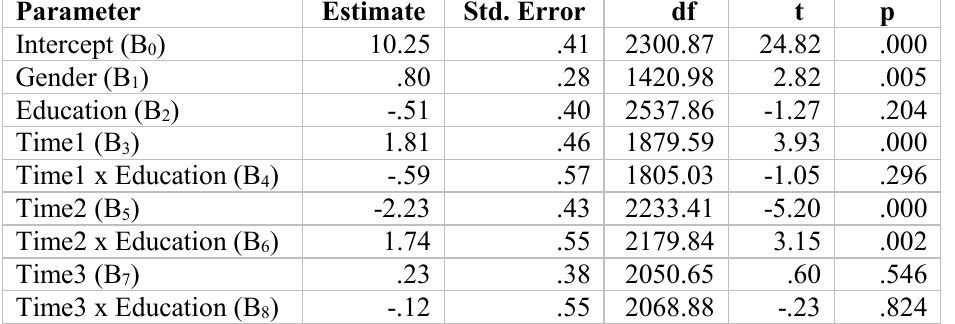
Estimates of fixed effects Parameter